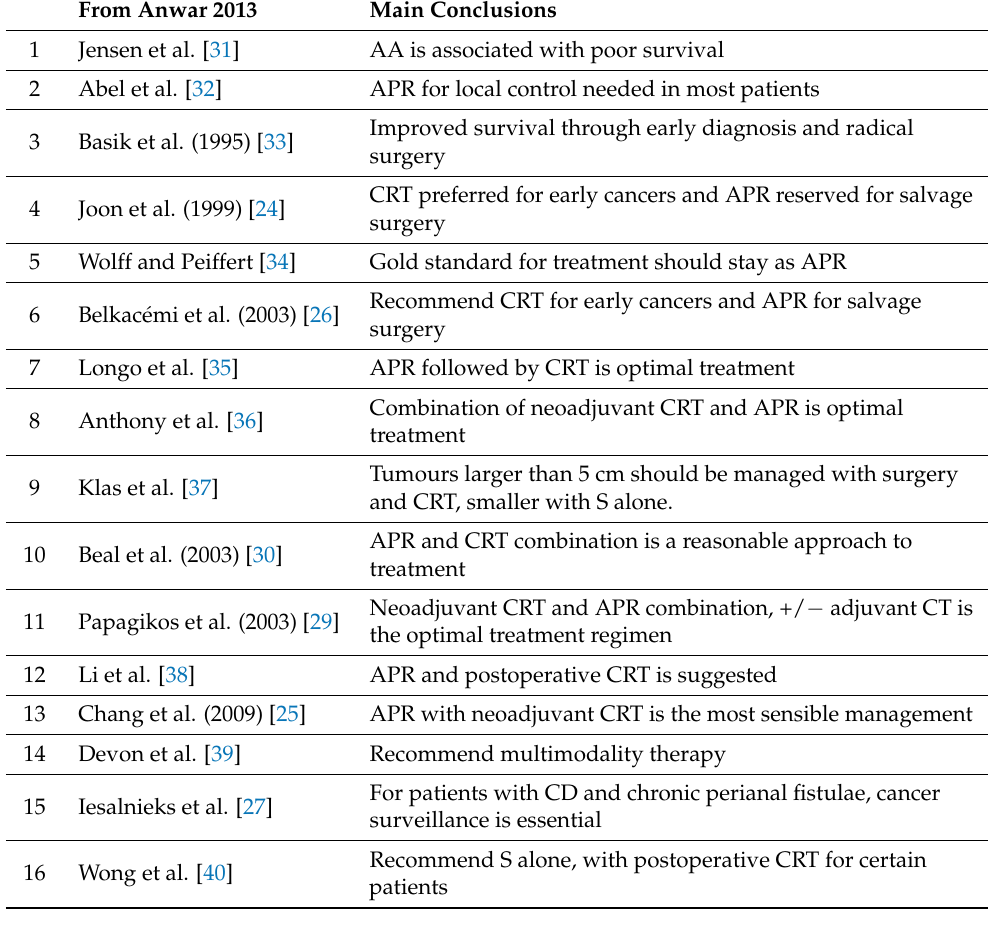
Table A1. Main conclusions of studies up to 2011 (reproduced from Anwar et al. [4]). From Anwar 2013 Main